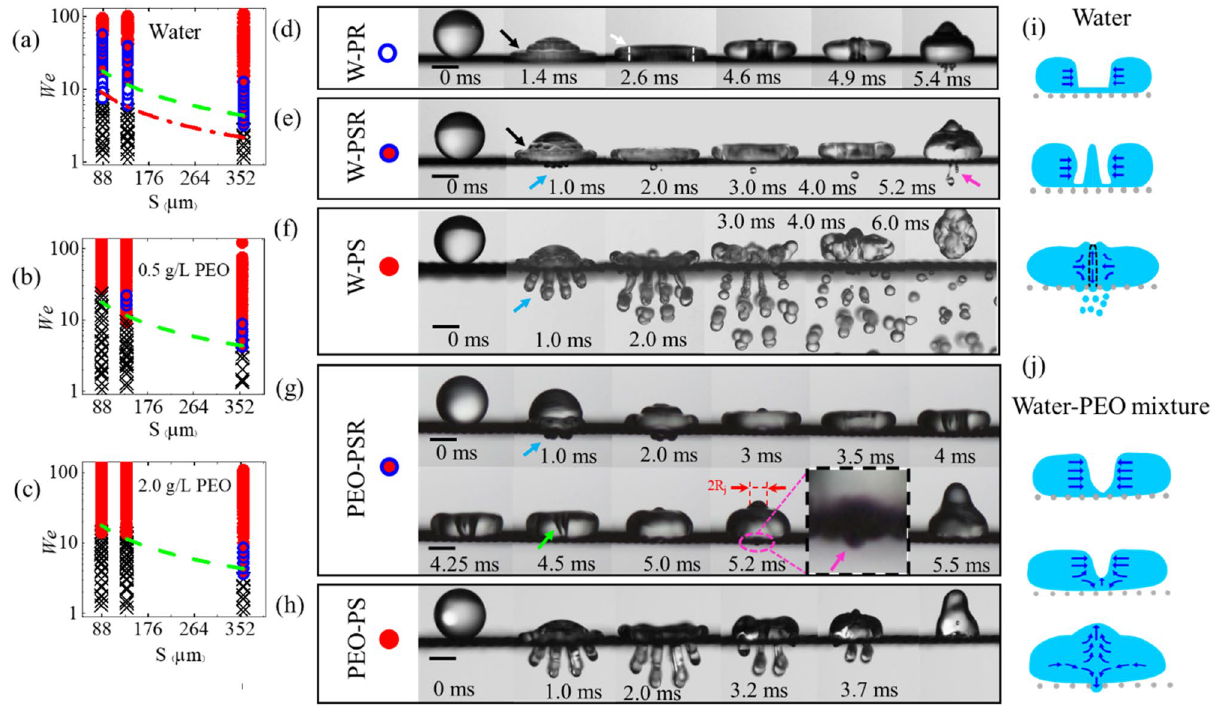
Figure 1. Phase diagram of the liquid penetration ( a ) water, ( b ) 0.5 g/L, and ( c ) 2.0 g/L PEO aqueous solution into the superhydrophobic mesh plotted in terms of the Weber number and the mesh pore wide S. The symbols represent different penetration phenomena which are defined in ( d–h ), symbol (x) shows no penetration. The green dashed line plots the threshold Weber number ( We cr1 ) for liquid penetration during droplet impact ( P D = P c ), while the red dashed-dotted line plots the experimental threshold of Weber number ( We cr2 ) for water droplet recoil penetration. ( d–h ) Time sequence photos of different types of penetration for ( d–f ) water droplets and ( d–h ) the PEO aqueous droplets impact on the superhydrophobic mesh when in ( d ) water penetrates the mesh during droplet recoiling (W-PR) at V 0 = 0.9 m/s; ( e ) water penetrates the mesh during both droplet spreading and recoiling (W-PSR) at V 0 = 1.15 m/s, ( f ) water penetrated the mesh during droplet spreading (W-PS) at V 0 = 1.3 m/s, ( g ) PEO aqueous droplet penetrates the mesh during both spreading and recoiling (PEO-PSR) at V 0 = 0.58 m/s and PEO concentration 0.5 g/L; ( h ) PEO aqueous droplet penetrates the mesh only during spreading (PEO-PS) at V 0 = 1.39 m/s and PEO concentration 3 g/L, the ligament retract back to their mother droplets. The penetration during the spreading and recoiling are denoted by blue and pink arrows, respectively. The scale bars in ( d–h ) are 1.0 mm. ( i ) Schematic diagram of the symmetry cavity collapse for water droplet observed at 4.6–5.2 ms in ( d ). ( j ) Schematic diagram of the cavity detachment observed for PEO aqueous solution at 4.0–5.25 ms in ( g